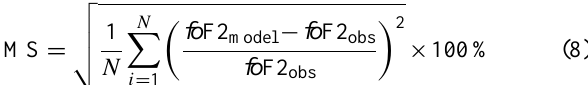
large (e.g., Bilitza et al., 1998, 2006; Bilitza and Williamson, 2000). For EOF model, the cumulative percentage variances of the first 4-order coefficients associated with the principal components of EOF analysis during solar high activity years are higher than that in solar low activity years. No matter for high or low solar activity years, the correlation coefficients between the EOF modeled values and the observational val- ues, which are 0.9757 and 0.9490 respectively, are higher than that for IRI model. So the EOF model can